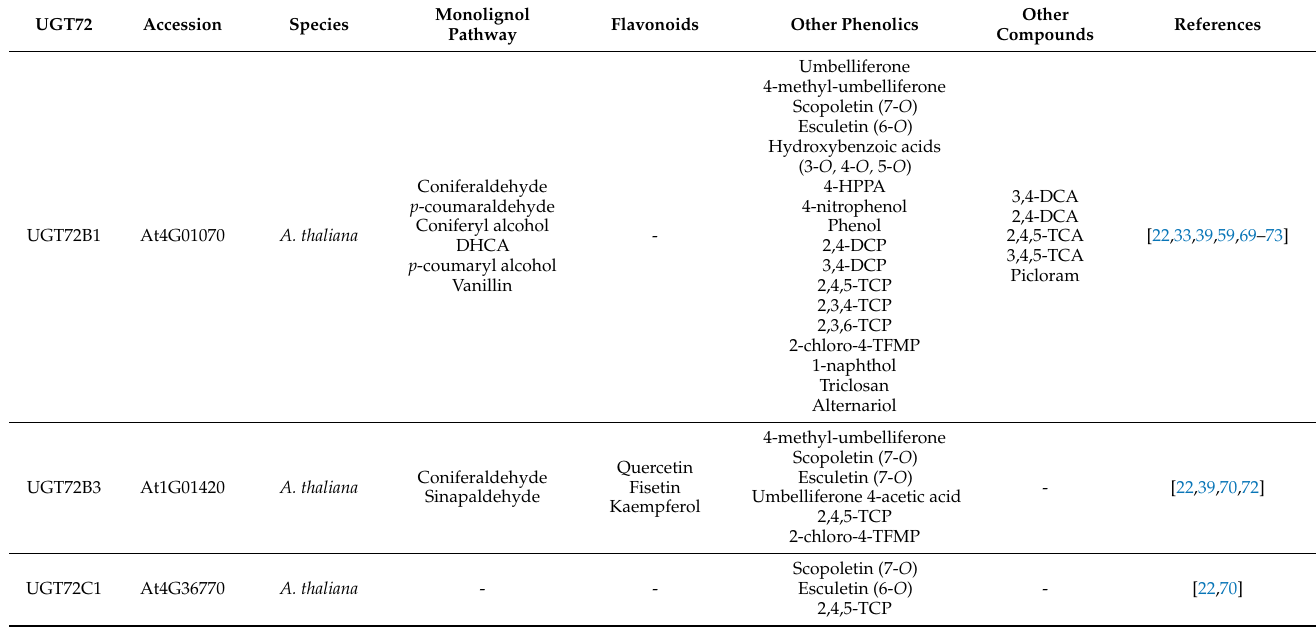
Table 2. Known in vitro substrates of 30 recombinant UGT72 proteins distributed into 12 an- giosperm species. The regiospecificity of the glycosylation is noted between brackets when determined. All UGT72s use UDP-glucose as sugar